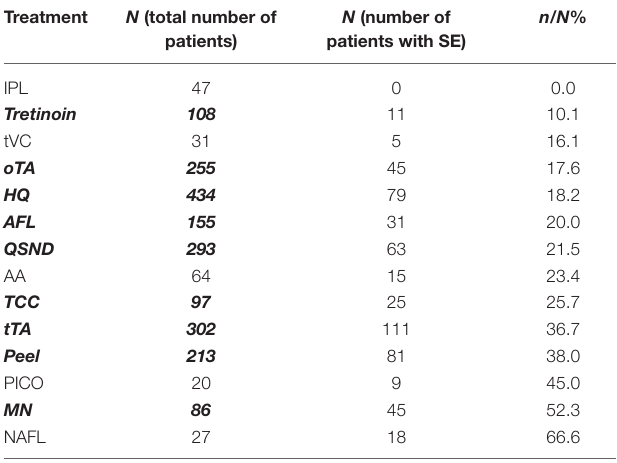
TABLE 1 | Ranking of competing treatments included in the network for melisma. Treatment